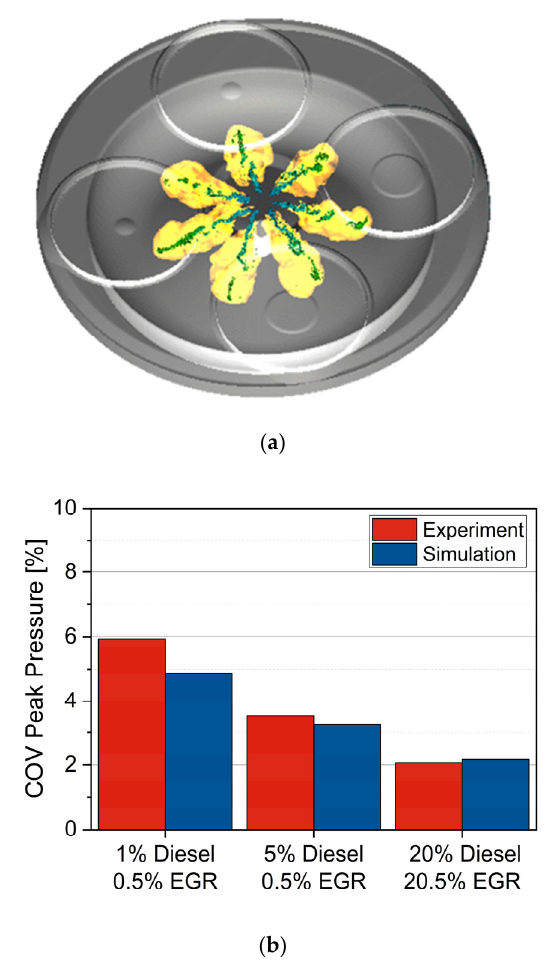
Figure 6. ( a ) Snapshot of the duel fuel combustion at 10° after TDC showing the spray parcels and an iso-surface of the progress variable; ( b ) Comparison between simulated and measured cycle-to-cycle variations for a large dual fuel engine with different diesel substitution rates.